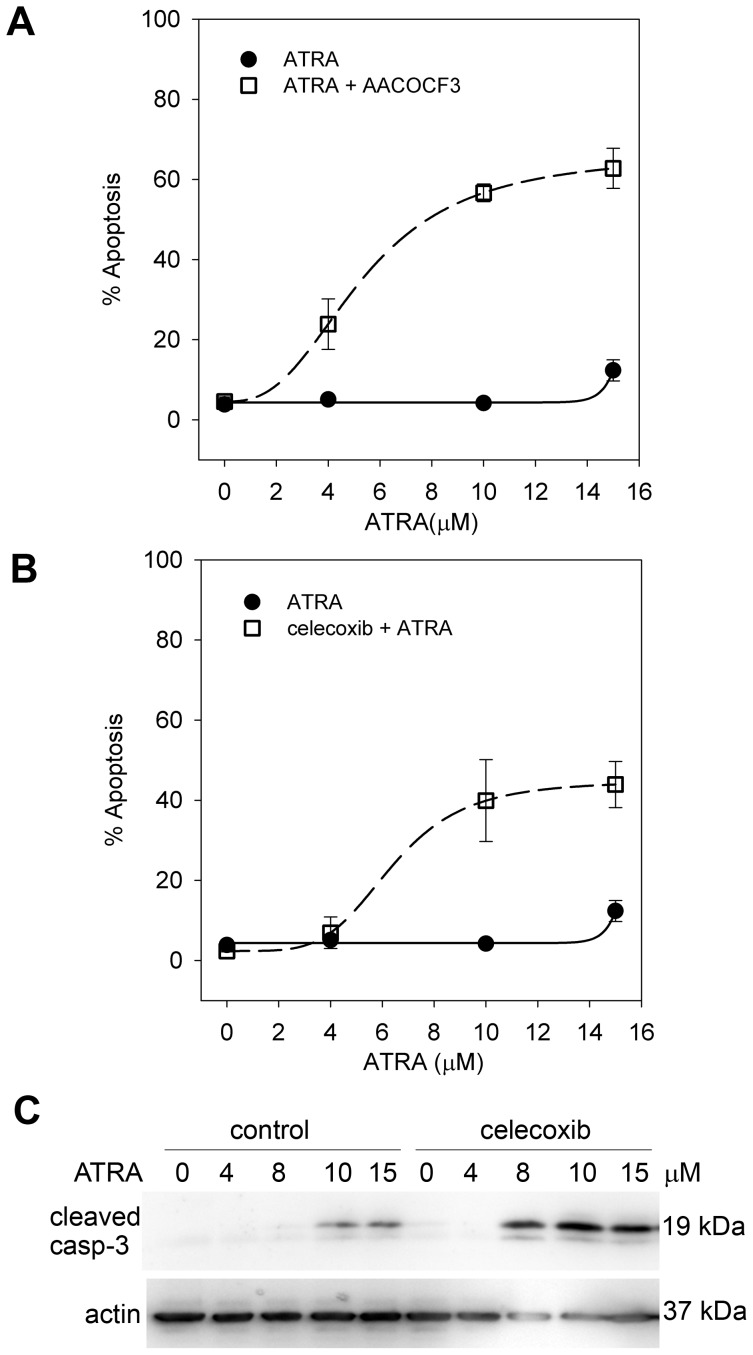
Inhibition of AA metabolism promotes RA mediated cell death.All graphs show data for SH-SY5Y cells. Apoptosis was measured after 24 h of treatment using flow cytometry in (A) and (B). The apoptotic fraction was determined as the sub-G1 peak. (A) Apoptosis of cells treated with ATRA alone (•, solid line) or ATRA in combination with 10 µM of the PLA2 inhibitor AACOCF3 (□, dashed line). Levels of apoptosis were significantly higher in the SHSY5Y cells treated with a combination of ATRA and AACOCF3 (ANOVA, P<0.001). (B) Apoptosis of cells treated with ATRA alone (•, solid line) or ATRA in combination with 22 µM celecoxib (□, dashed line). The interaction P-value for ATRA and celecoxib was P = 0.03 (ANOVA). For apoptosis experiments there were three technical replicates for each of three dose response curve experiments. Viability results for the corresponding experiments are summarised in Table 1 with additional viability data for NGP and NB89 cells in Table S1. (C) Western blot for cleaved caspase-3, 6 h after treatment with ATRA or ATRA with 22 µM celecoxib, size markers from ladder are shown; the full blot is shown in Figure S3.